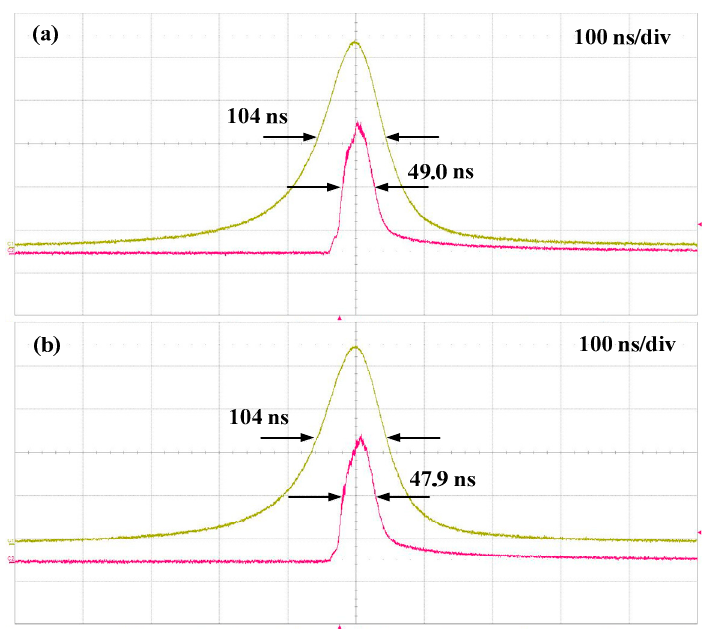
Figure 3. Oscilloscope traces of pump ( upper ) and Raman ( lower ) laser pulses: ( a ) first-stage amplifier and ( b ) second-stage amplifier.